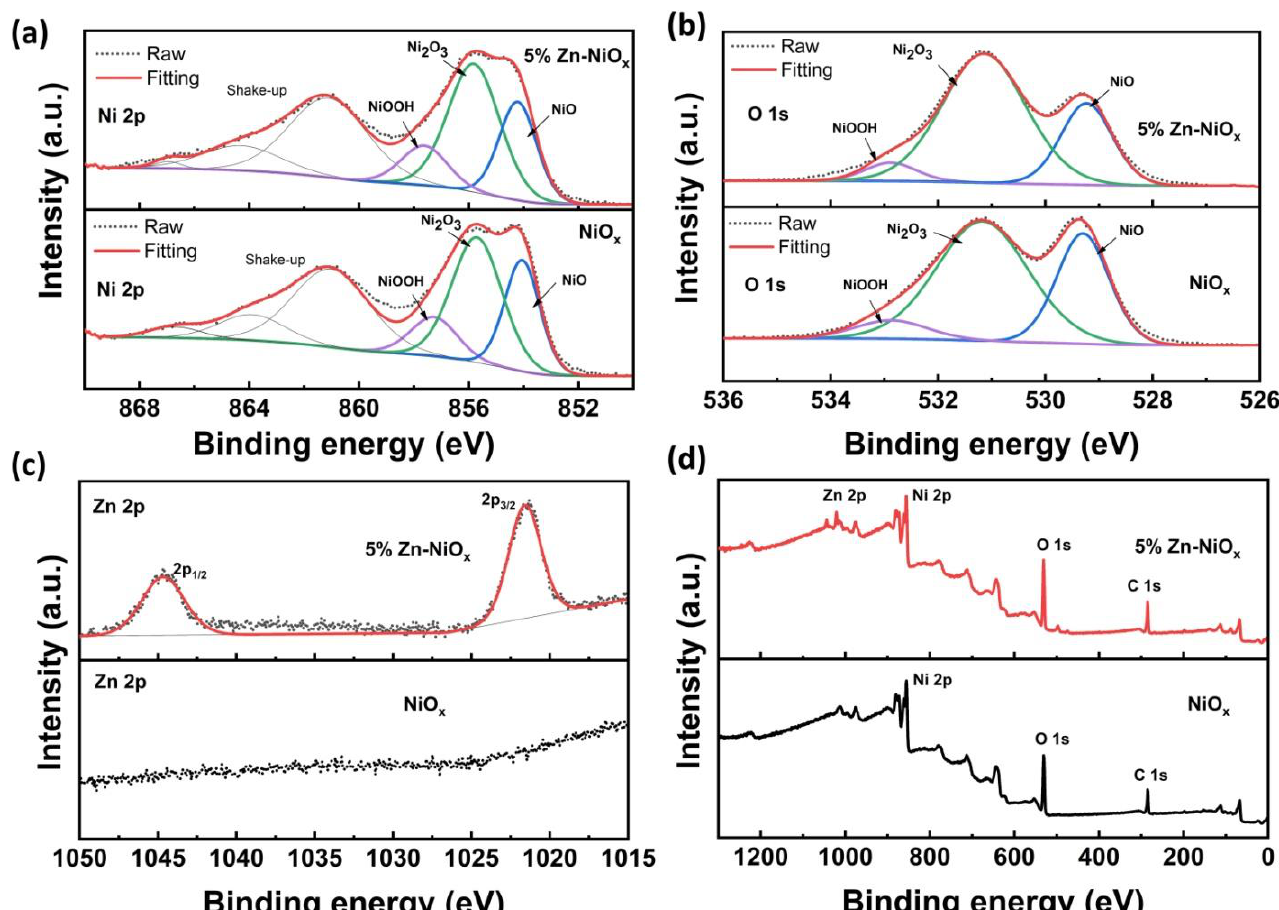
Figure 5. XPS spectra of ( a ) Ni 2 p , ( b ) O 1 s , ( c ) Zn 2 p , and ( d ) survey scan for NiO x and 5% Zn-NiO x thin films. The surface morphology of NiO x and 5% Zn-NiO x thin films annealed at 250 °C was analyzed by field emission scanning electron microscopy (FESEM). The top view of the FESEM image and energy-dispersive X-ray spectroscopy (EDS) results for NiO x and 5% Zn-NiO x thin films are shown in Figure 6a,b, respectively. Both films exhibit similar morphology and better coverage without any voids on FTO substrate. A fine layer of these thin films is clearly seen on the FTO, and the 5% Zn doped NiO x film looks somewhat smoother than the pristine film. This observation was confirmed by AFM results. EDS results confirmed the presence of Zn in NiO x thin films. The atomic composition ratio was closely related to stoichiometry. Figure 6c shows the cross-sectional FESEM image of the device. The device was fabricated with an architecture of FTO/NiO x /MAPbI 3 /PCBM/BCP/Ag. All layers can be well distinguished from the cross- sectional FESEM image.